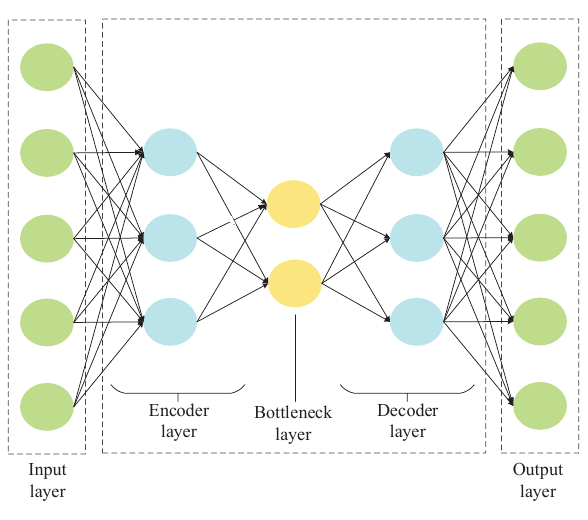
Figure 3. The autoencoder